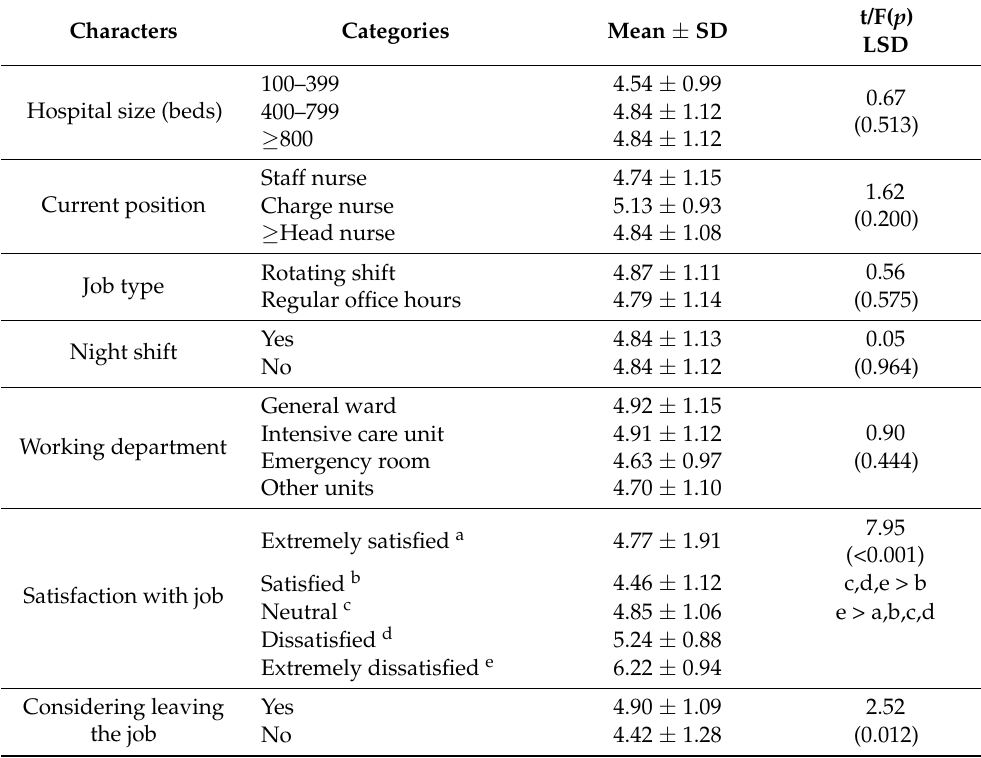
Table 5. Differences in WFC according to work-related characteristics ( n = 290).